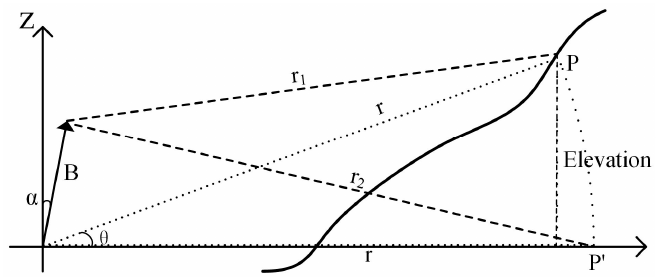
Figure 3. Flat-phase removal in GB-InSAR.